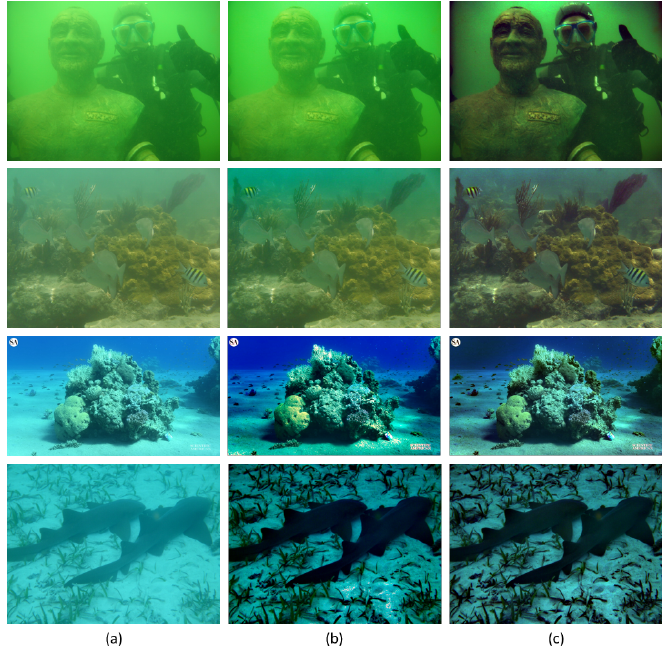
Figure 20. Underwater images from [45]: ( a ) input images, ( b ) images restored with our White fog algorithm (W), ( c ) images restored with the color version of our algorithm